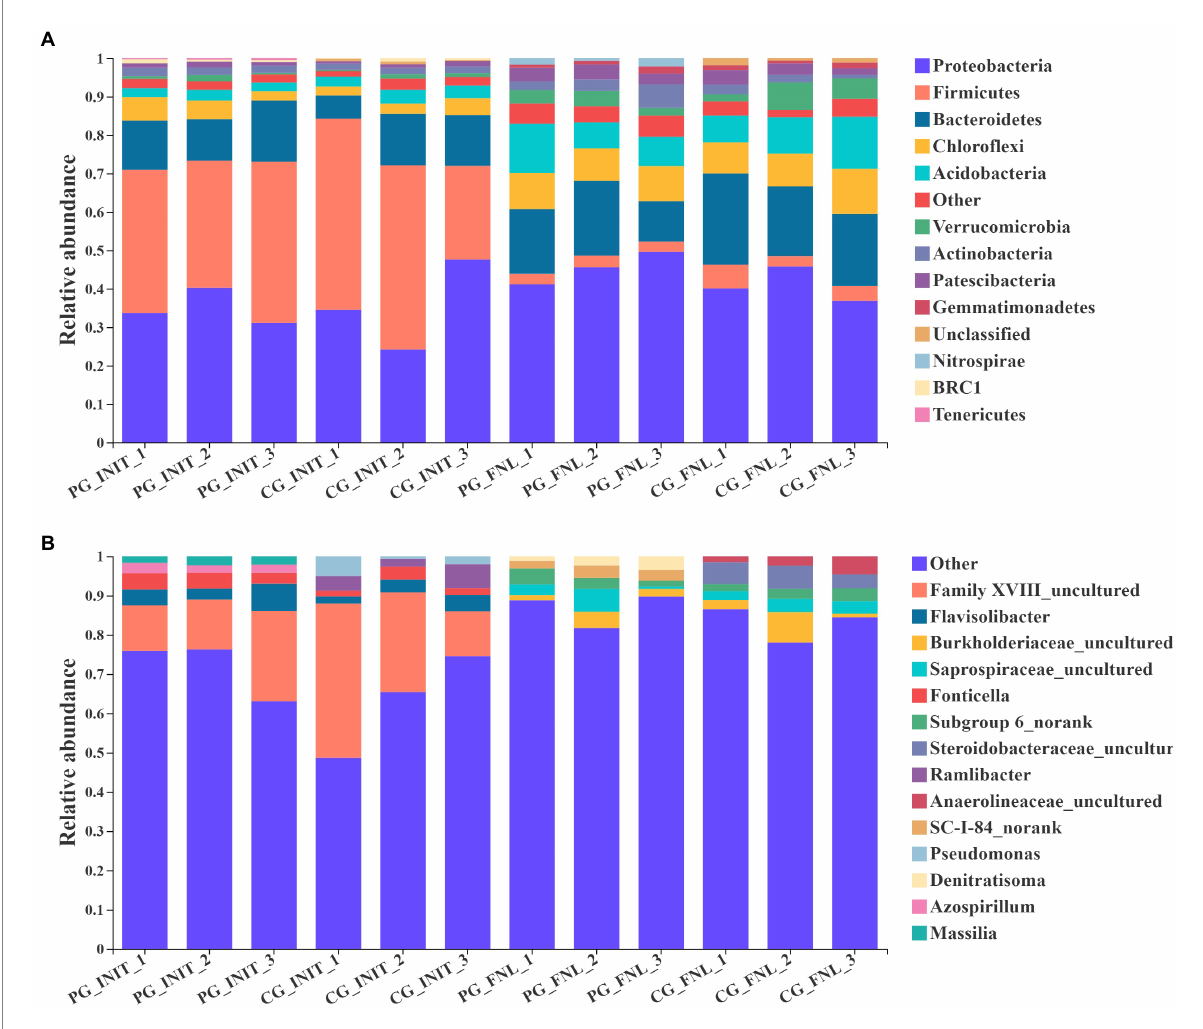
FIGURE 5 Relative abundances of the dominant phyla ( A , most abundant top 10) and genera ( B , most abundant top 5) in PG and CG groups at the initial and final stages of the experiment. PG_INIT and CG_INIT represented the PG and CG groups at the initial stage of the experimental period, respectively. PG_FNL and CG_FNL represented the PG and CG groups at the final stage of the experimental period,